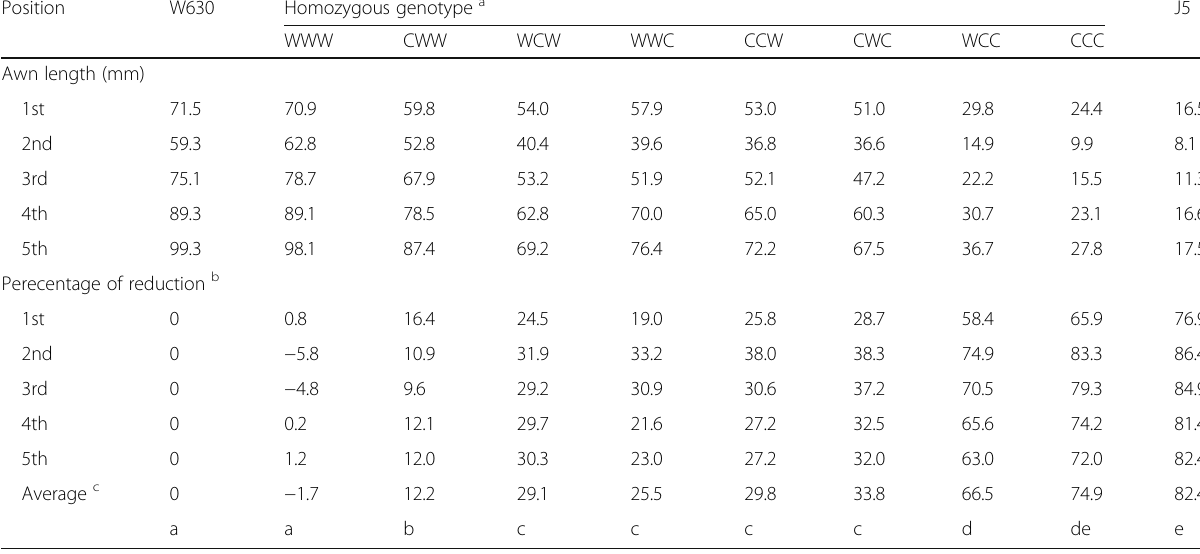
Table 3 Average lengths and reduction percentages of the awns in the 1st to 5th spikelet positions of eight homozygous genotypes and the parental accessions of O. rufipogon W630 and the J5 line Position W630 Homozygous genotype